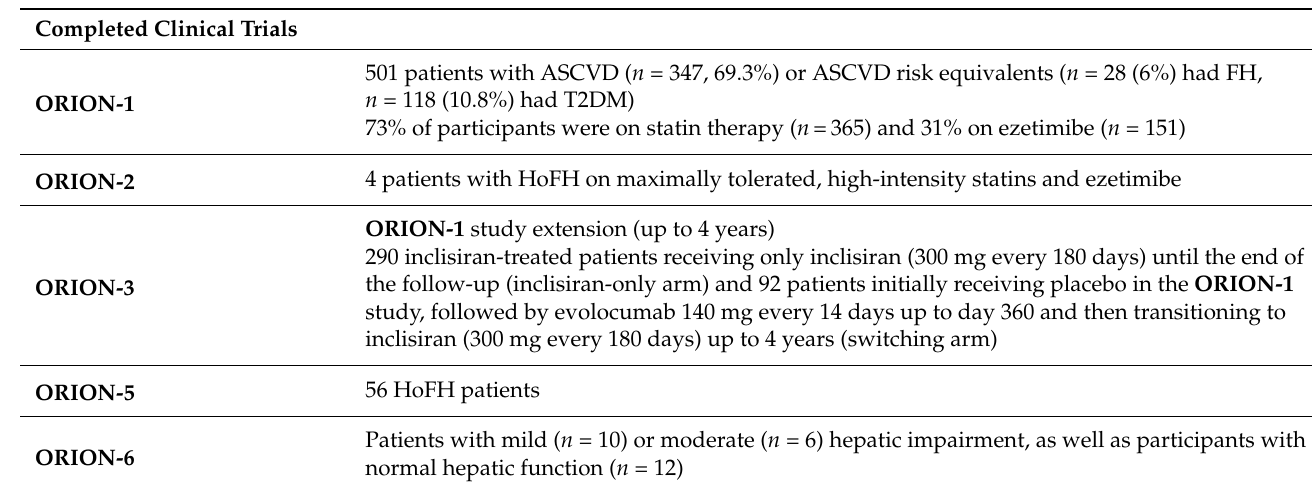
Table 1. Patient populations in the ORION and VICTORION